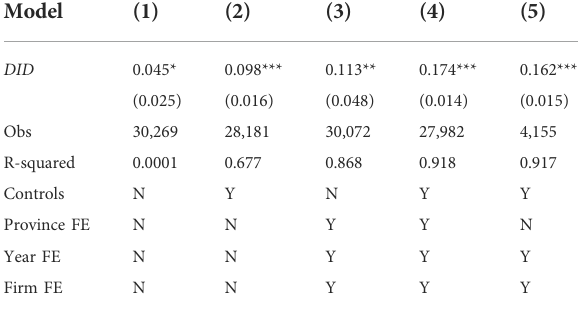
TABLE 3 Baseline regression